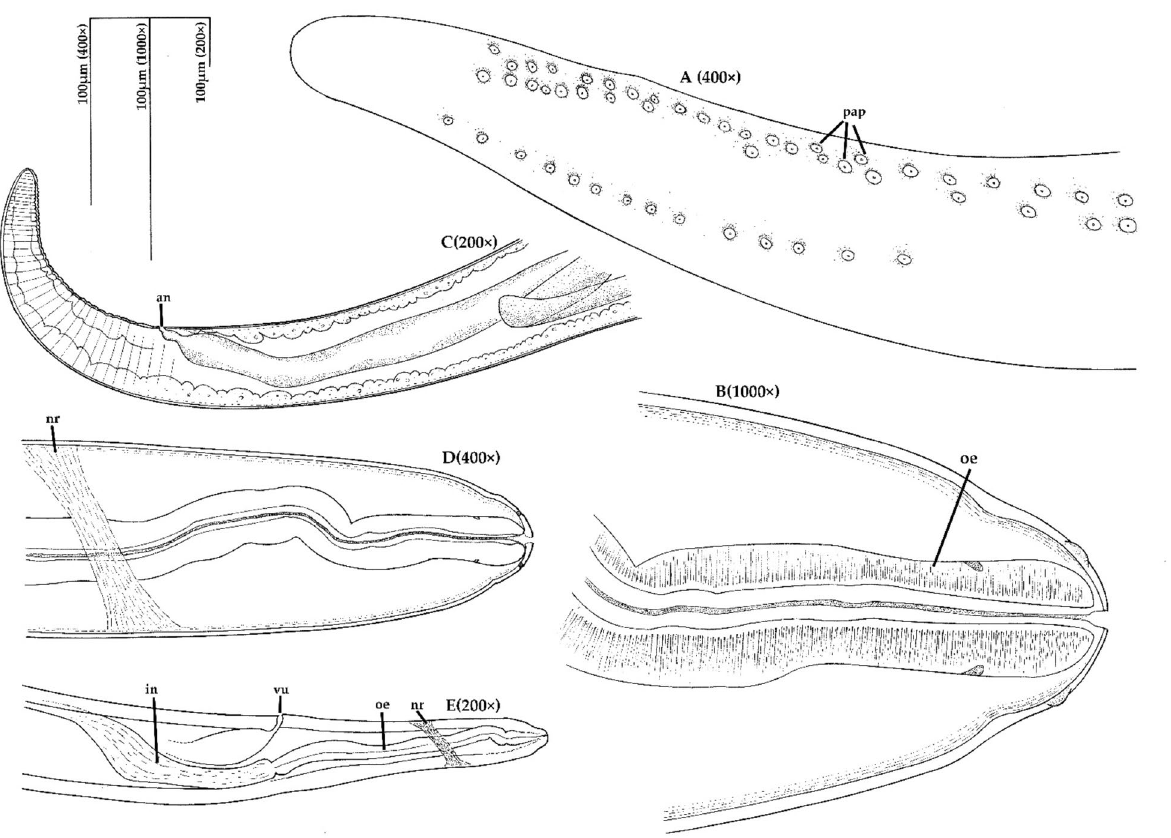
Figure 6. Schematic view of anterior and posterior extremities of a female specimen. ( A ) Posterior part, immature female, ventral view; ( B ) anterior part, ventral view; ( C ) posterior part, lateral view; ( D ) anterior part, ventral view; ( E ) anterior part, lateral view. Abbreviations: an-anus, oe-oesophagus, vu-vulva, nr-nerve ring, in-intestine,